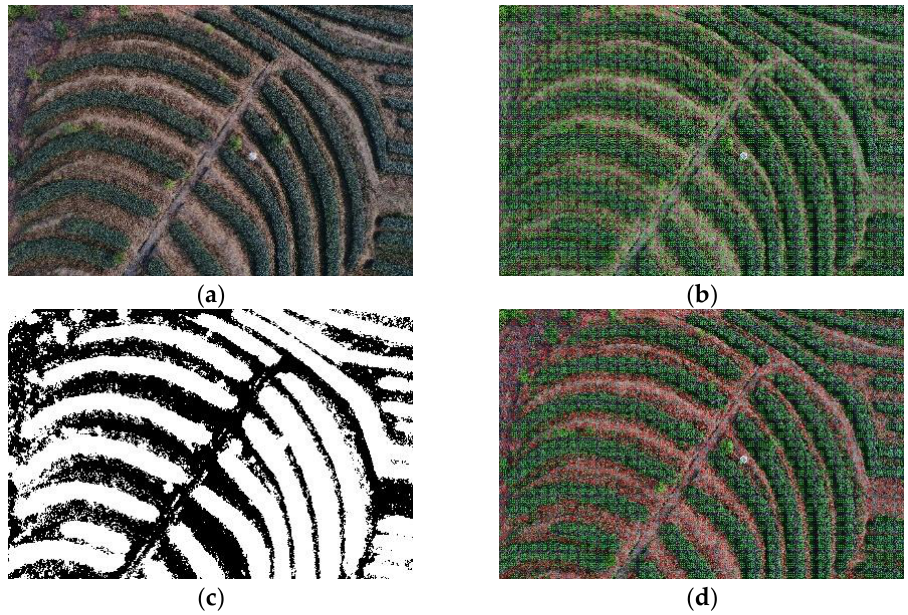
Figure 12. Point set extraction and filtering. ( a ) Raw image; ( b ) image by point set extraction; ( c ) binary mask image calculated by RGRI indices; and ( d ) image after filtering.